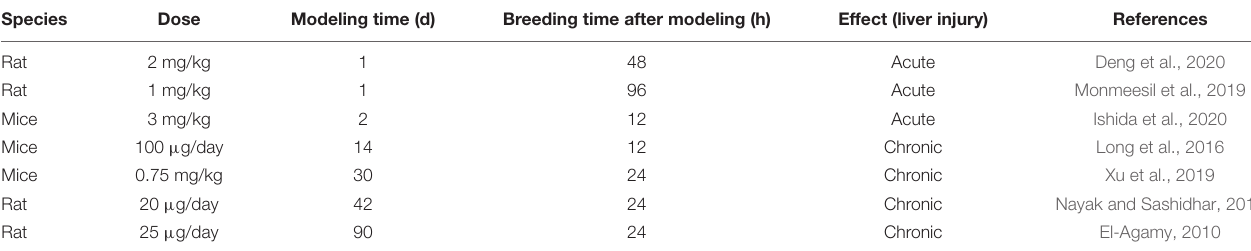
TABLE 1 | Different animal models were established to explore the effects of AFB 1 on liver. Species Dose Modeling time (d) Breeding time after modeling (h) Effect (liver